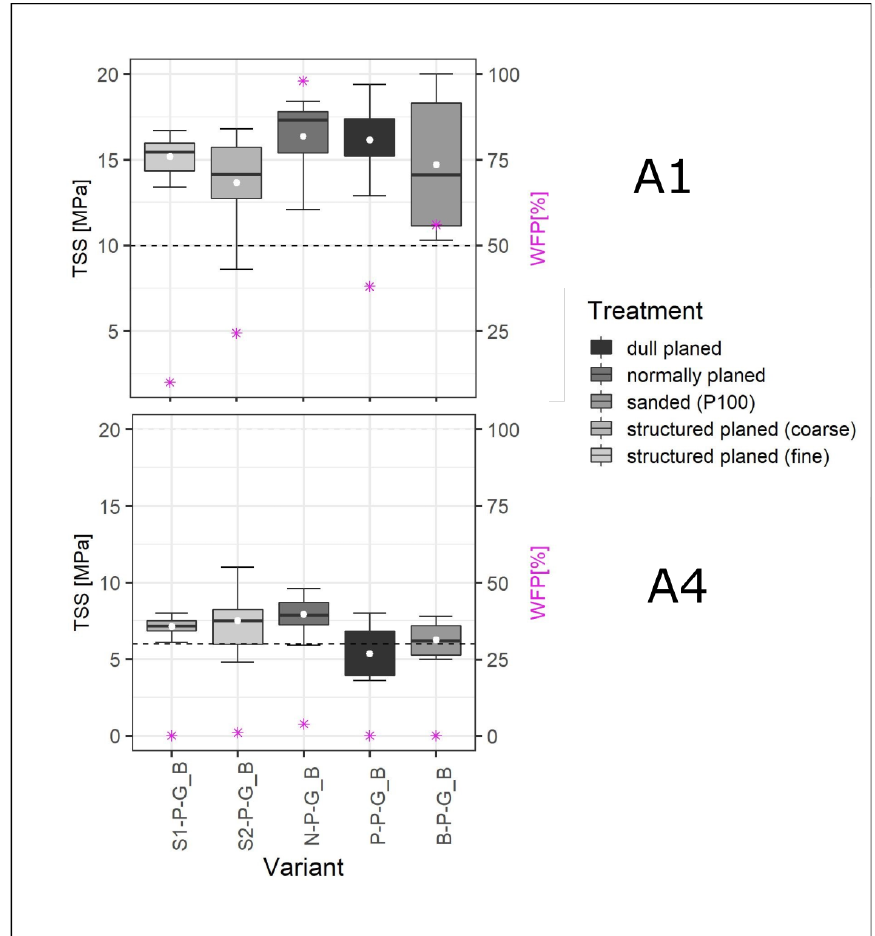
Figure 4. Tensile shear test results of five different surfacing methods using a one-component PUR at 125 g/m 2 . Boxplots show minimum and maximum values, the white point displays the arithmetic mean value, and the thick horizontal line represents the median. The black point stands for the outlier value. The dashed line shows the minimum value allowed. The first graph represents dry stage results, and the second graph from the top shows results of the A4 test. On the right axis, the asterisks represent the wood failure percentage